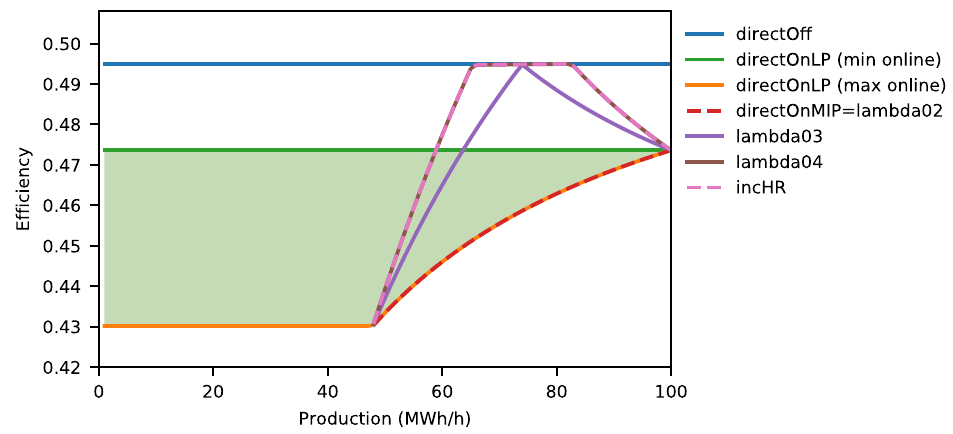
Figure 5. Efficiency approximations for an example unit. The resulting efficiency of the linear online variable approximation (directOnLP) depends on how much of the unit is online—the possible area is highlighted in green. Integer online variable with no-load fuel use and linear input/output (directOnMIP), λ -approximations (lambda02-lambda04) and stepwise incremental heat rates (incHR) only allow the unit to operate above the minimum load, which is 48 MW in the example. Without online variables (directOff), the unit adopts its maximum